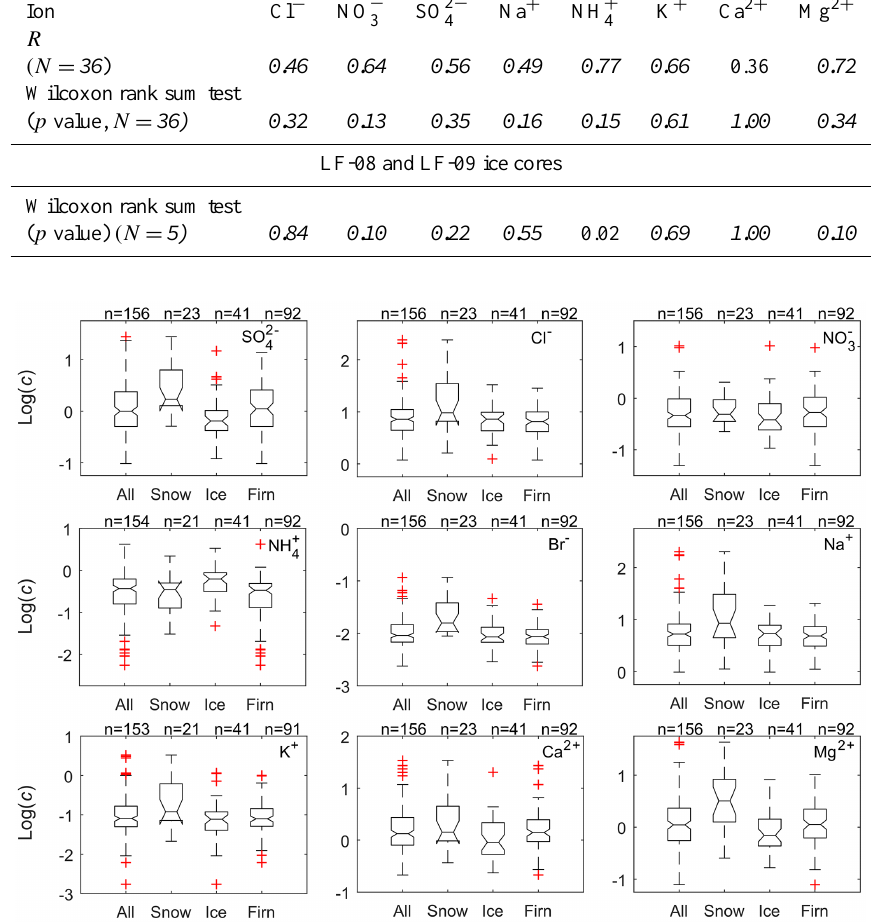
Figure 4. Box plot of ionic concentrations (Log( c)) found in the different stratigraphic units in the LF-11 ice core between 2004 and 2011. n represents the sample size in each stratigraphic unit, and whiskers are Tukey